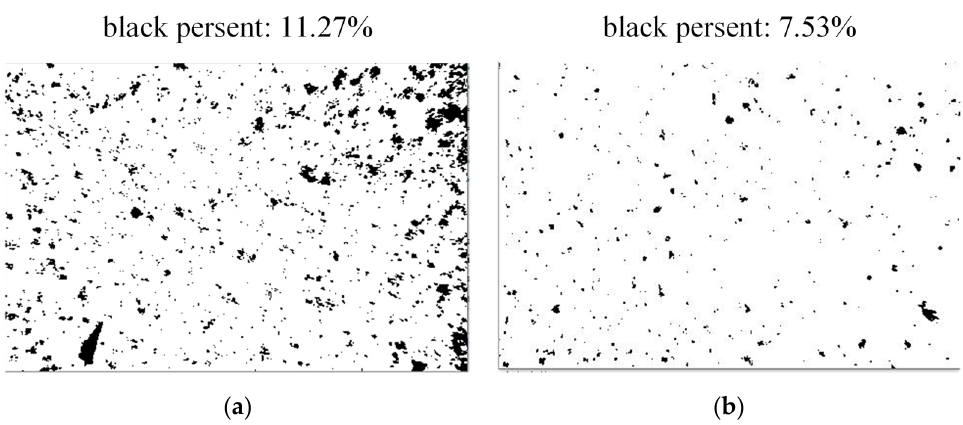
Figure 14. Binarized images with di ff erent water contents: ( a ) 0.021 g; ( b ) 0.216 g.